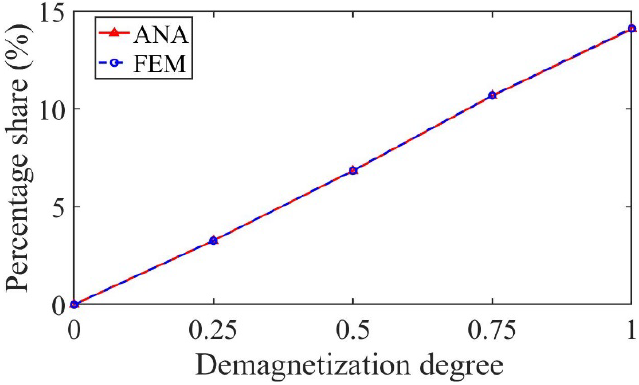
Figure 14. Variation in the percentage share of the harmonic with demagnetization degree.